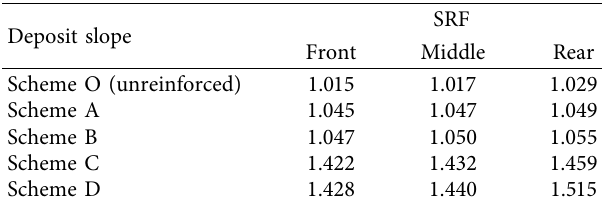
Table 4: Critical strength reduction factor (SRF) of reinforcement